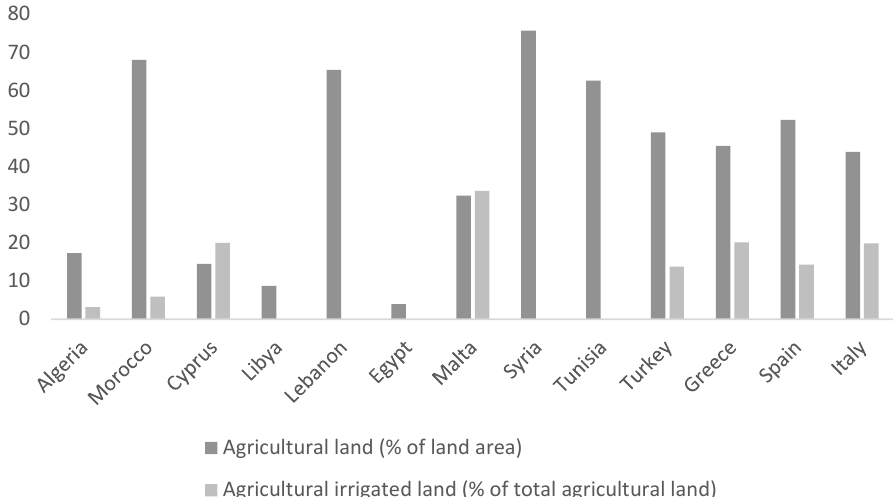
Figure 3. Total agricultural land and total irrigated land in the Mediterranean countries. Source of data: World Bank.